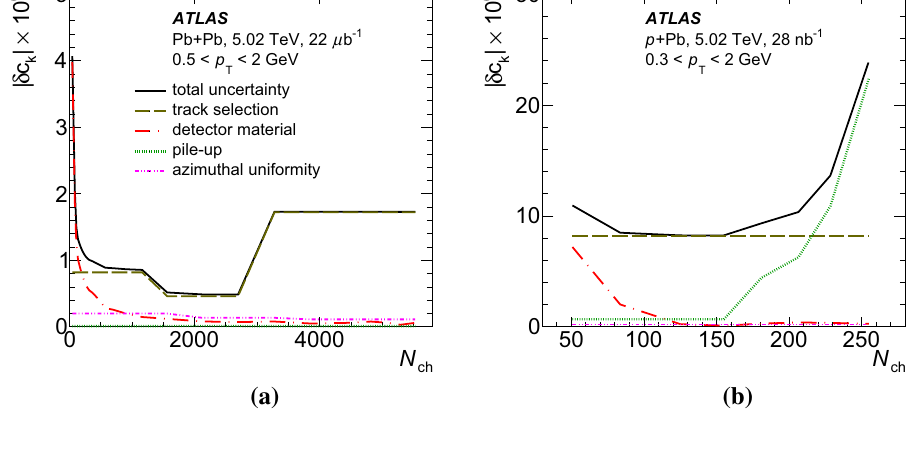
Fig. 8 The systematic uncertainty of c k as a function of N ch measured with tracks from main p T intervals in a Pb+Pb collisions and in b p +Pb collisions. The total